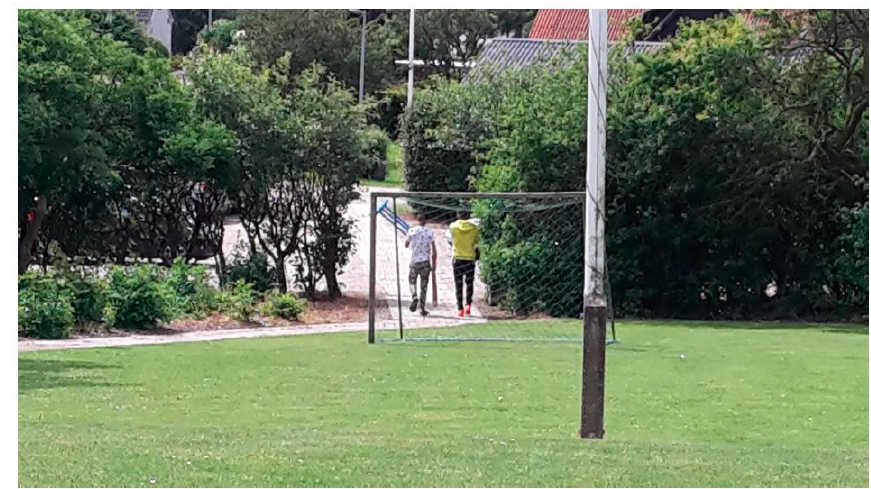
Figure 2. Two of the boys from the centre on their way to play cricket (Source: Authors, 2021). Category 4: relationships with teachers and